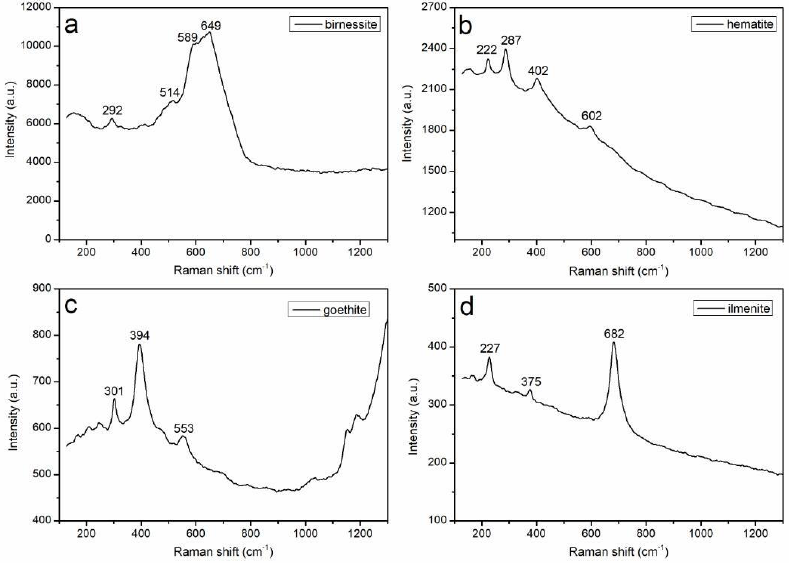
Figure 3. Raman spectra of the soil Fe / Mn coating. ( a ) Birnessite; ( b ) hematite; ( c ) goethite; ( d )